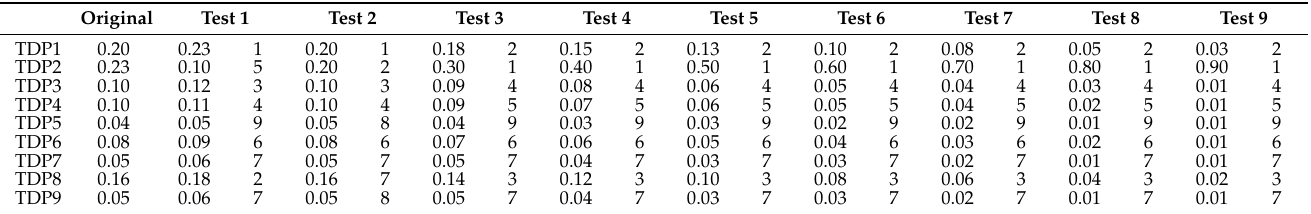
Table A1. Technology 4.0 driven practices weight and ranks for sensitivity analysis in various test.